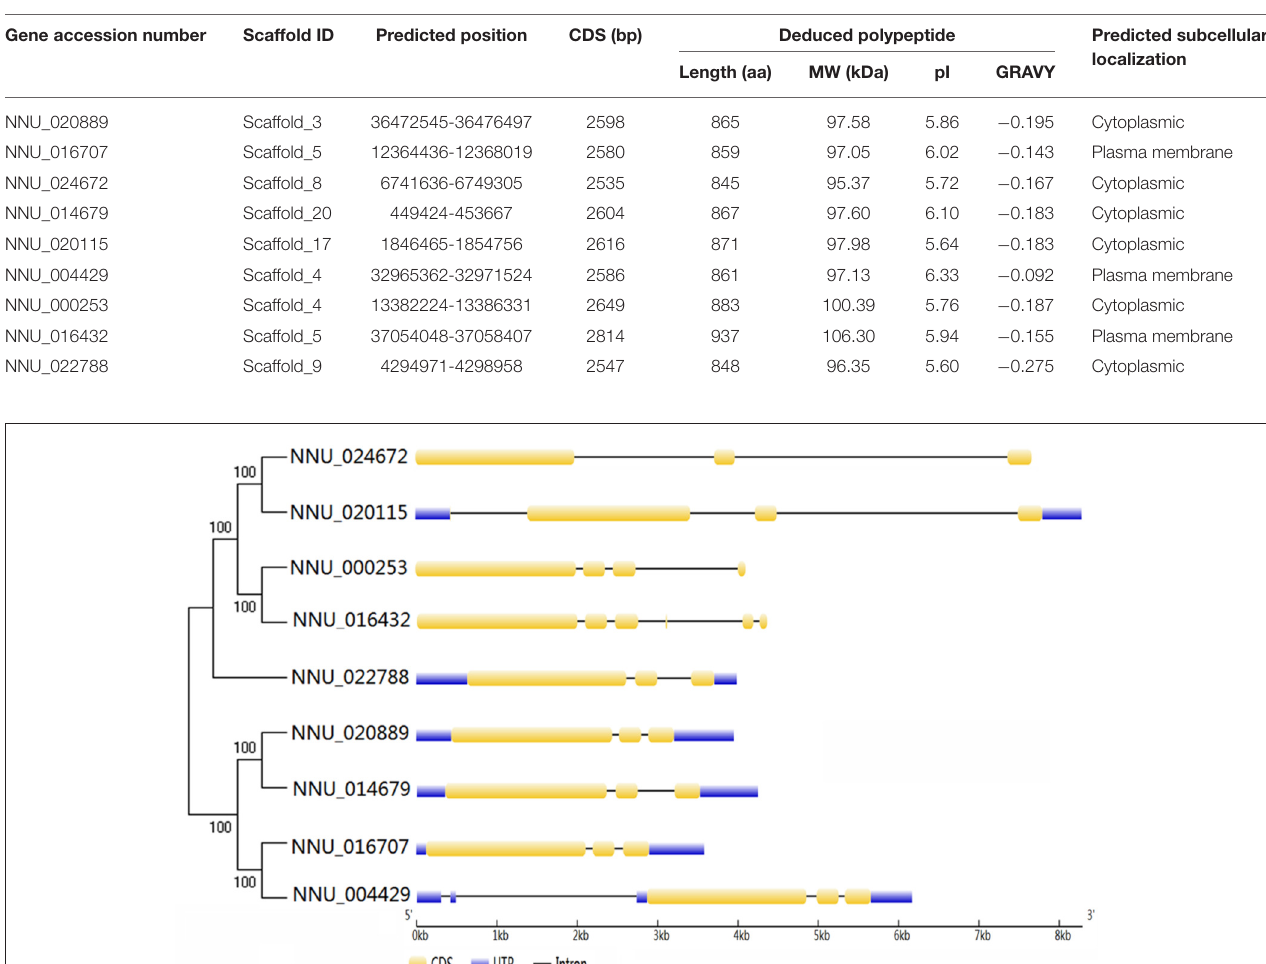
TABLE 1 | List of the NnTPS genes identified in this study.